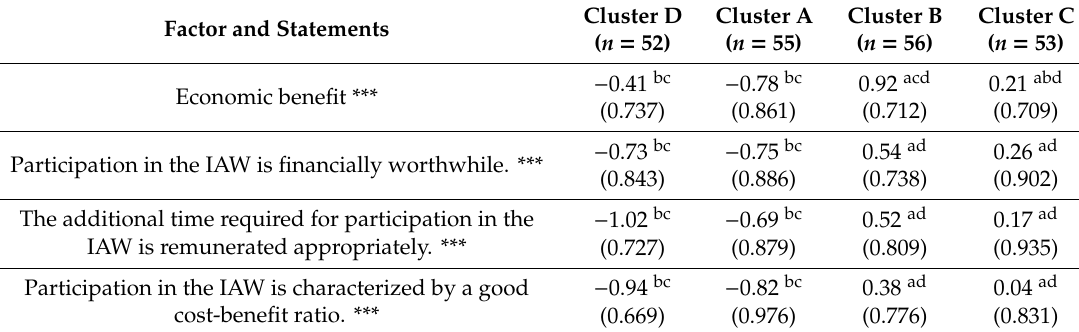
Table 2. Results of the cluster